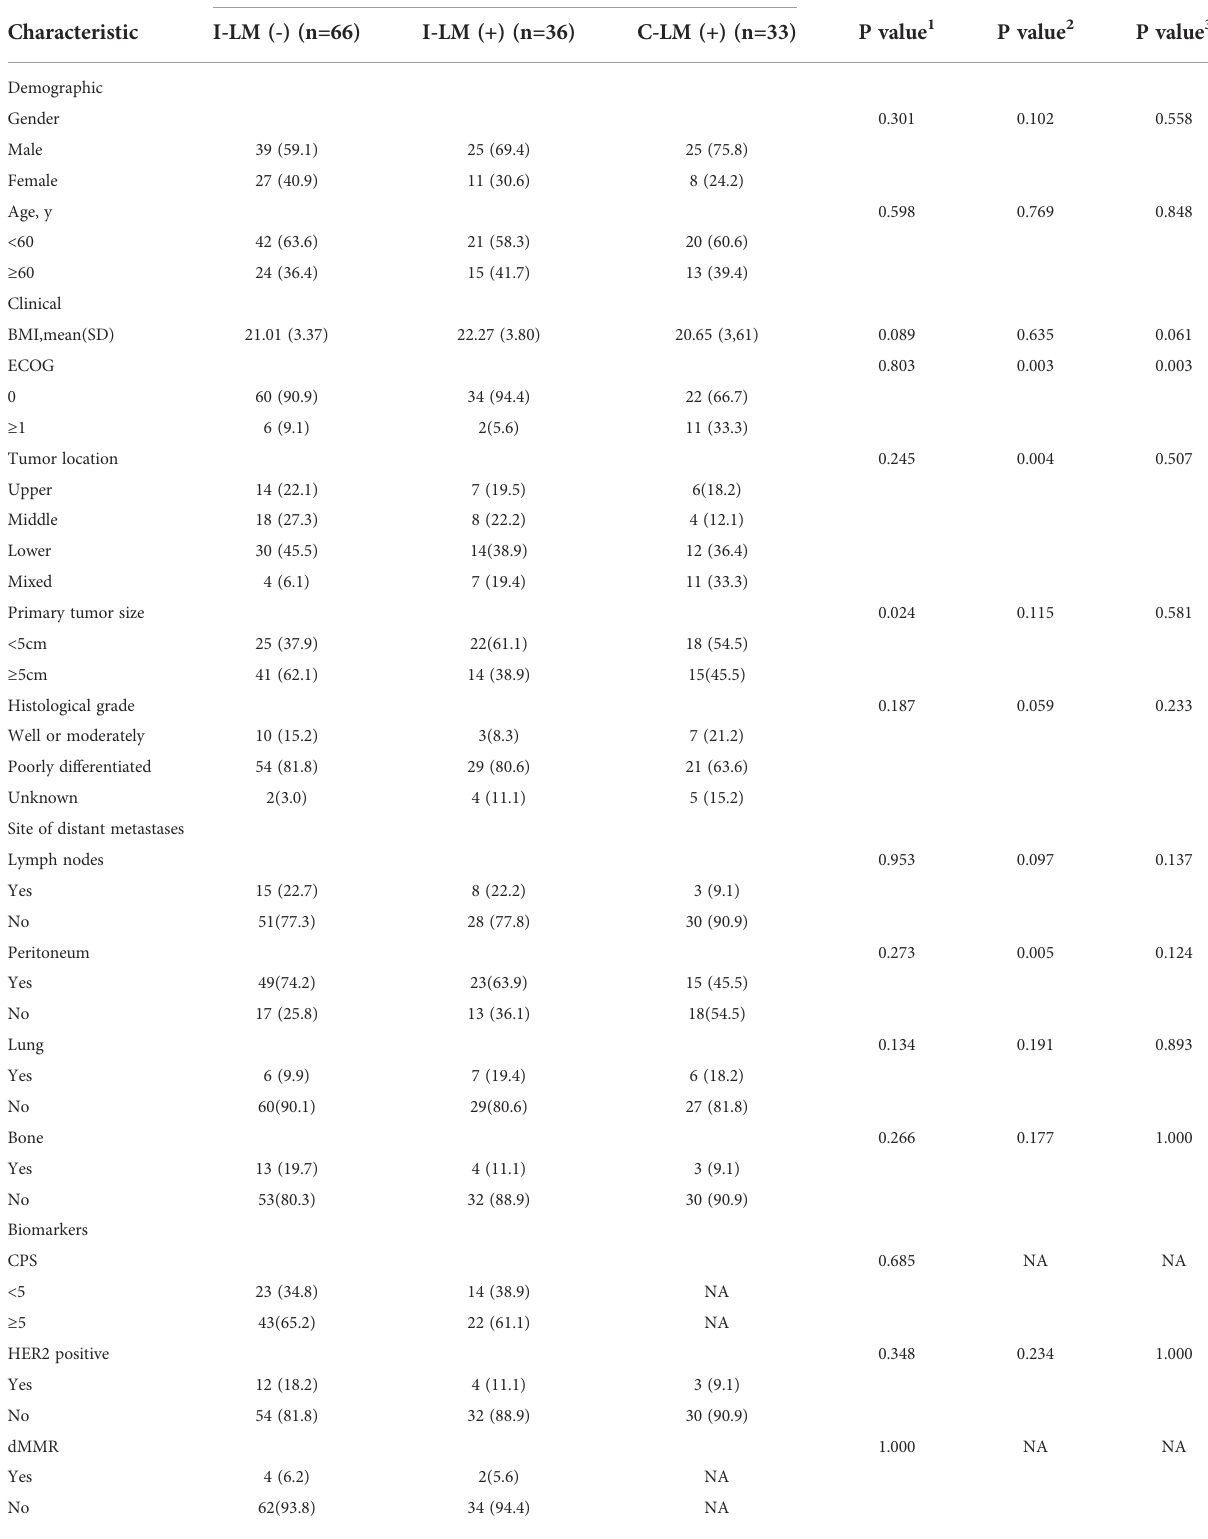
TABLE 1 Baseline characteristics of patients before fi rst treatment in the I-LM(-) group, I-LM(+) group, and C-LM(+) group, respectively. Patients, No.